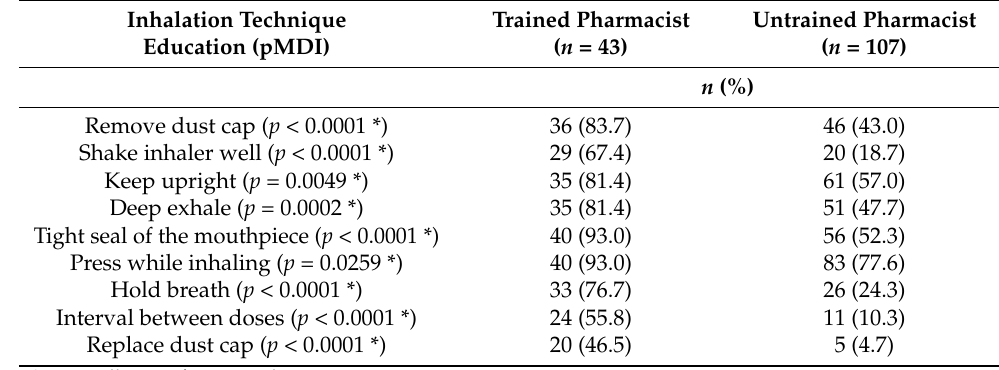
Table 1. Information about the inhalation technique during patient education, determined by the pharmacist’s level of training ( n = 150). Inhalation Technique